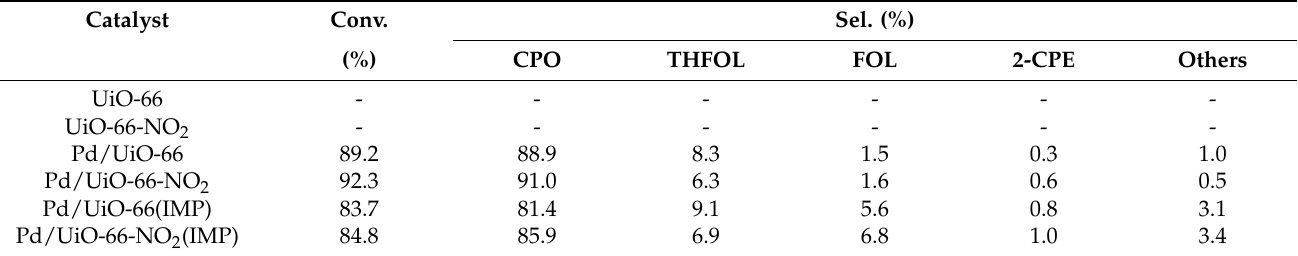
Table 2. Hydrogenative ring-rearrangement of FAL to CPO over different